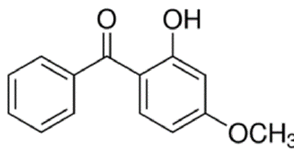
Figure 1. Chemical structure of benzophenone-3 (BP-3).